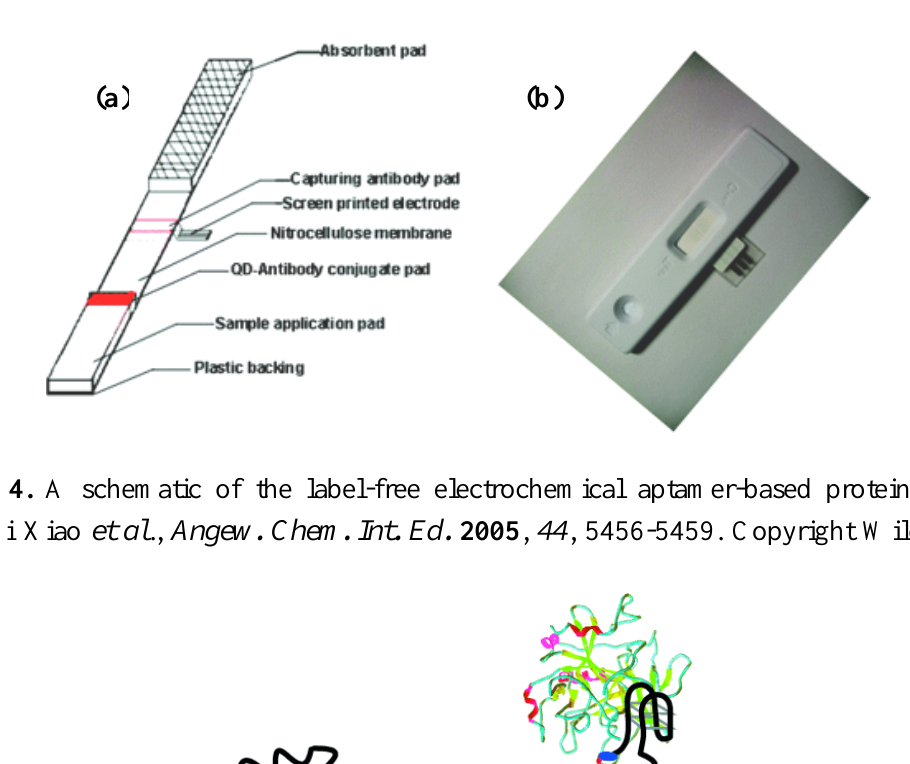
Figure 3. (a) Schematic illustration and (b) photograph of the disposable electrochemical immunosensor diagnosis device. From Liu et al ., Anal. Chem . 2007 , 79 , 7644-7653. Reprinted with permission from ACS.